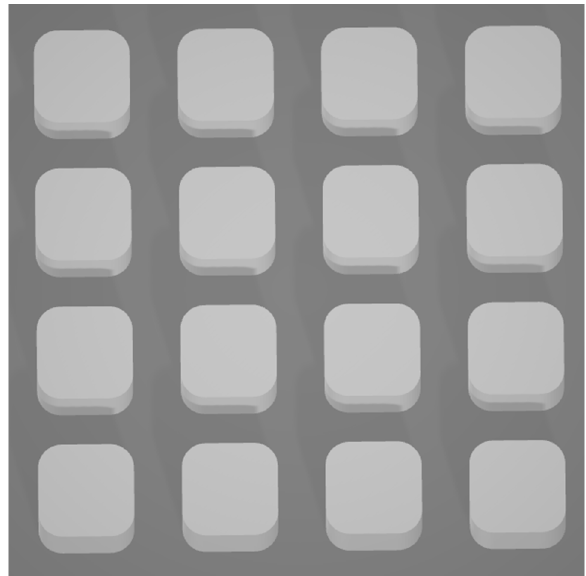
Figure 2. A standard tessellation language file image for the standard specimens to be printed.